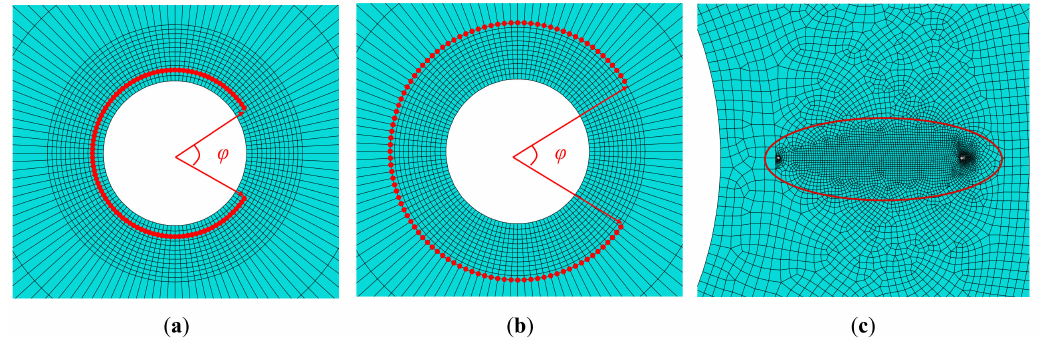
Figure 2. The meshes of the interfacial and radial cracks in the simulation: ( a ) the bonded nodes marked in red at the casing-cement interface; ( b ) the bonded nodes marked in red at the cement-formation interface; ( c ) the radial crack meshed with the refined mesh.